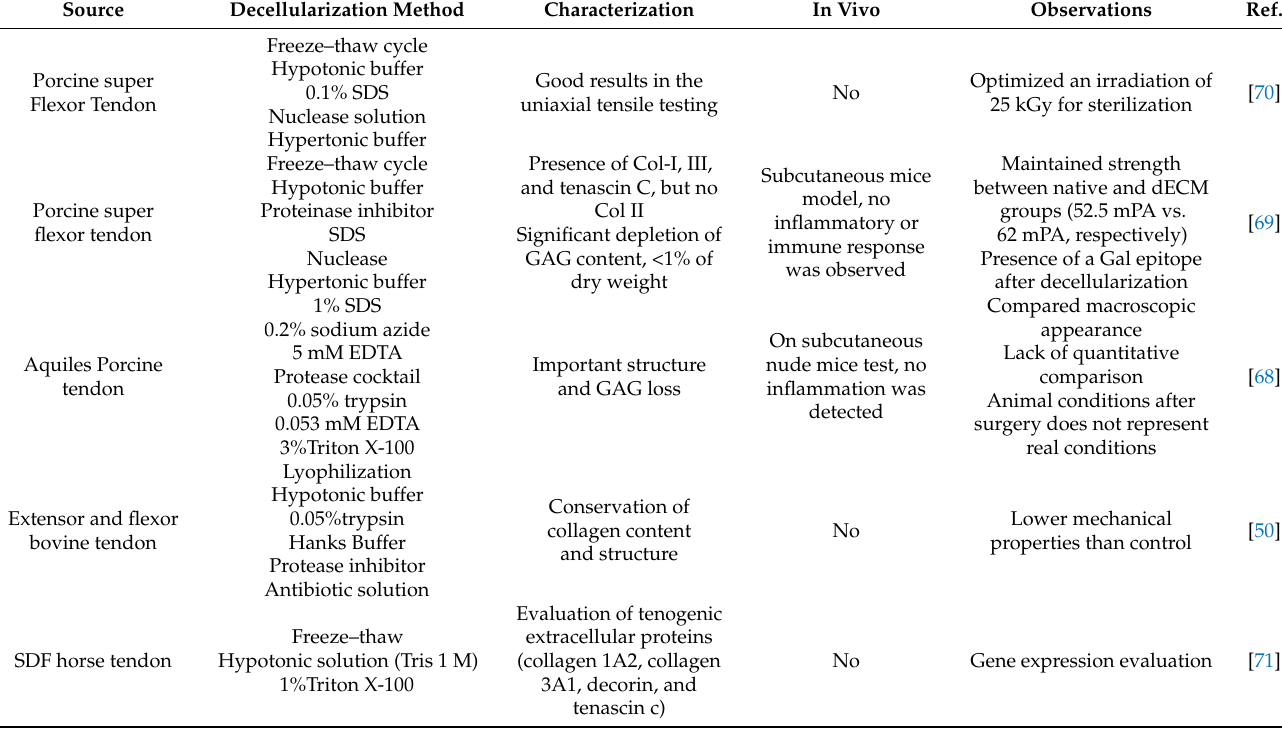
Table 3. Tendon decellularization